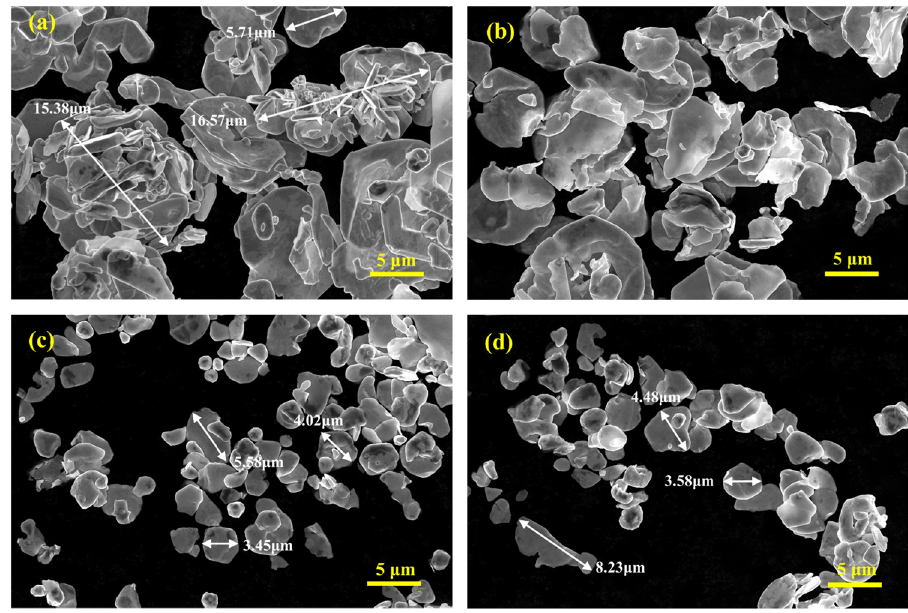
Figure 4: SEM of the silver powder prepared with di ff erent dispersant addition: ( a ) 0.4%, ( b ) 0.6%, ( c ) 0.8%, and ( d )